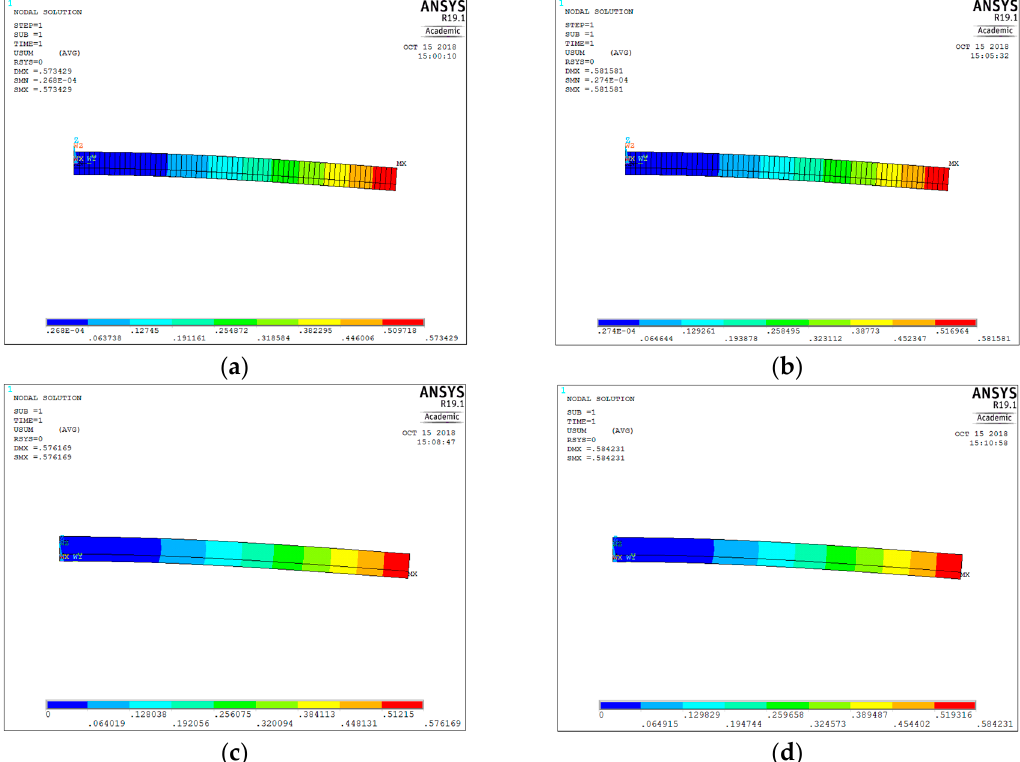
Figure 4. Displacement vector of the composite beam for the isotropic mechanical model ( a ), isotropic electro-mechanical model ( b ), orthotropic mechanical model ( c ), orthotropic electro-mechanical model ( d ). Units are in mm, kg, N, Vmm , MPa, N